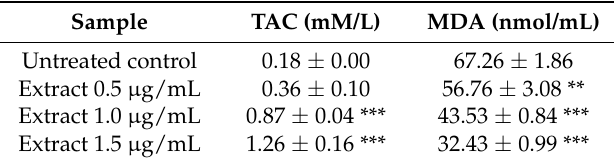
Table 3. Effect of A. harveyi leaf extract on total antioxidant capacity (TAC) and lipid peroxidation (malondialdehyde, MDA) in seminal plasma of bull frozen-thawed